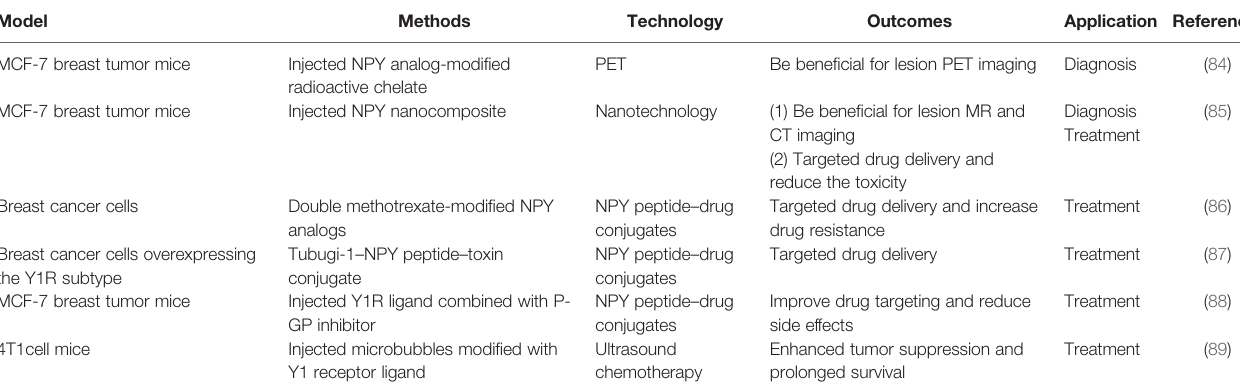
TABLE 2 | Several applications of NPY in the treatment of breast cancer.